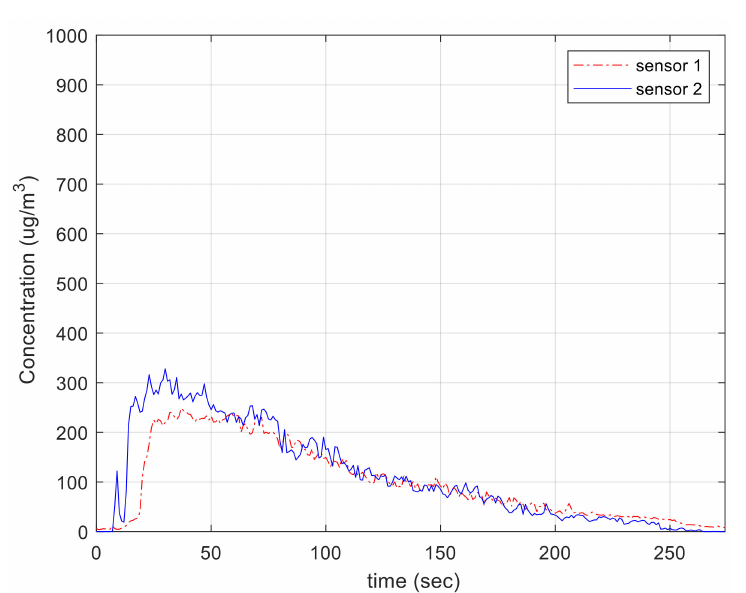
Figure 15. Performance evaluation: part-to-part repeatability using actual